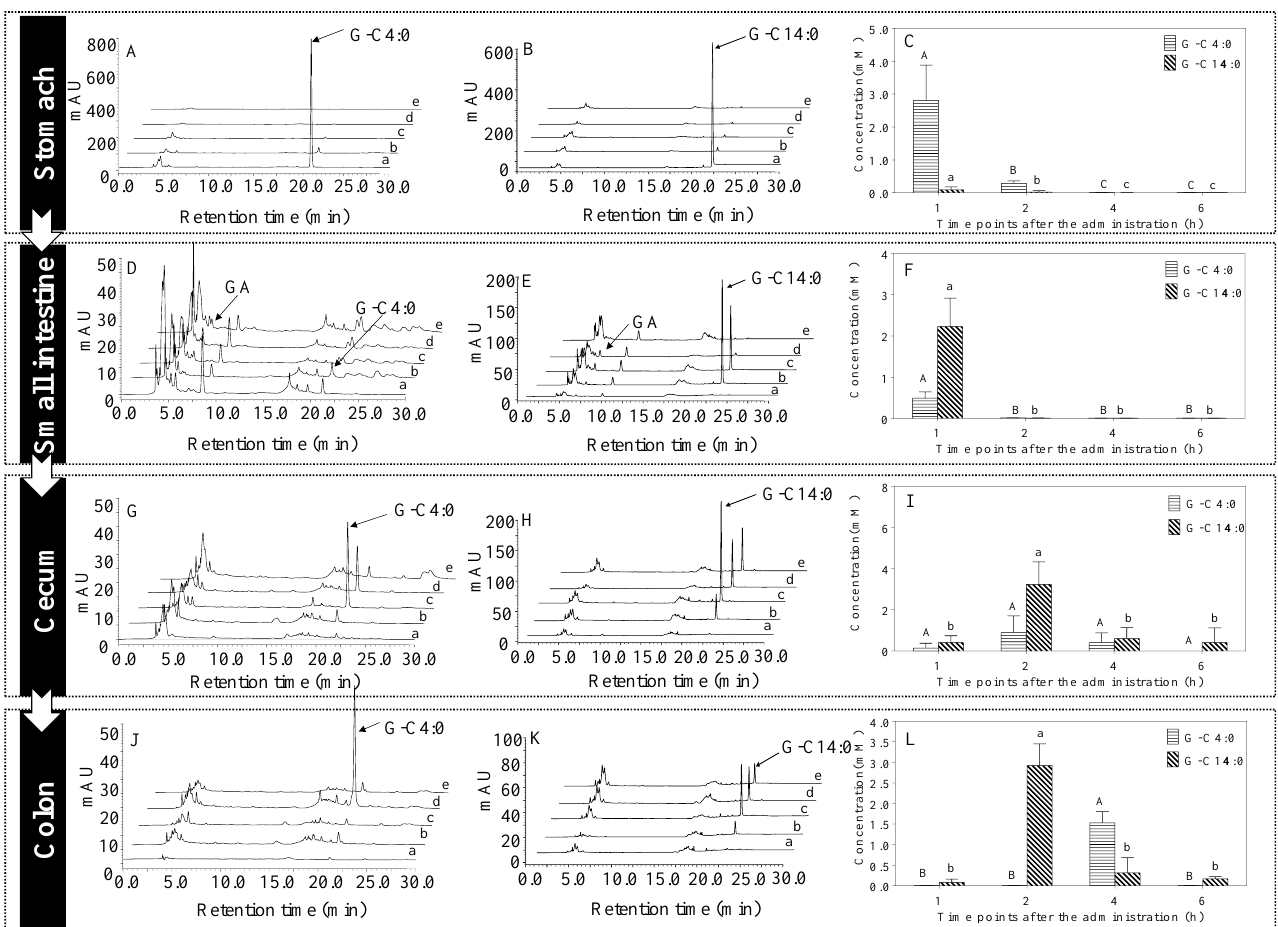
Figure 2. HPLC-UV chromatograms (G-C4:0 group-( A , D , G , J ); G-C14:0 group-( B , E , H , K )) and the concentrations of G-C4:0 and G-C14:0 in the contents of the stomach ( C ), small intestine ( F ), cecum ( I ) and colon ( L ) (n = 8): 0, 1, 2, 4 and 6 h (a – e, respectively). Bars with different letters (A – C, a – c) are statistically different ( p < 0.05).